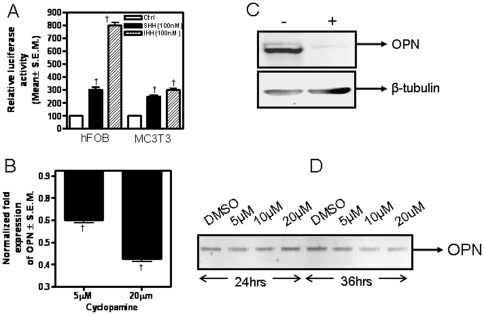
Hh signaling regulates OPN expression in osteoblastic cells.(A) Hh ligands significantly increase the activity of OPN promoter in the preosteoblastic cell lines hFOB 1.19 and MC3T3 E1 Sc-14 († indicates p<0.0001 for all indicated groups). Cells were transfected with OPN promoter, treated with Hh ligands at the indicated concentrations and assessed for luciferase activity. (B) The Hh pathway inhibitor, cyclopamine (20 µg/ml), decreased the expression of OPN transcript († indicates p<0.0001). hFOB 1.19 cells were treated with cyclopamine for 24 hours and assessed by quantitative real time RT-PCR for OPN expression. The expression of total OPN, from the cell lysate (C) as well as secreted OPN (D) is decreased in presence of cyclopamine. The decrease in the secreted OPN protein level is both, dose (5, 10 and 20 µM) and time dependent. hFOB 1.19 cells were treated with cyclopamine (20 µM for 24 hours; in panel C) and at theindicated concentrations and time intervals in panel D and assessed for expression of OPN by immunoblotting.